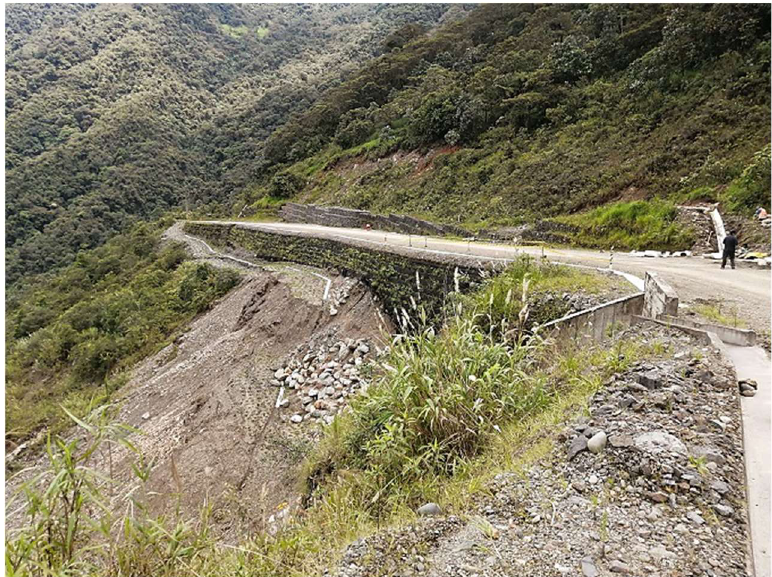
Figure 2. A view of the middle part of the landslide area where the road was affected (cut) and reconstructed, applying observed earth-walls. In this location, the movement is prone to continue at a low displacement tax. The high slope on the landscape can be observed.